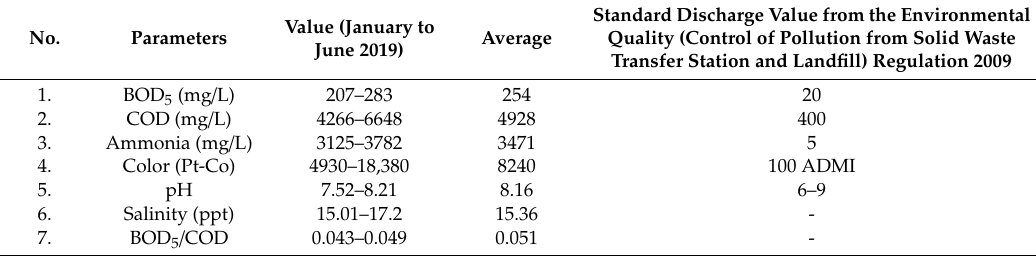
Table 3. Characteristics of Pulau Burung landfill